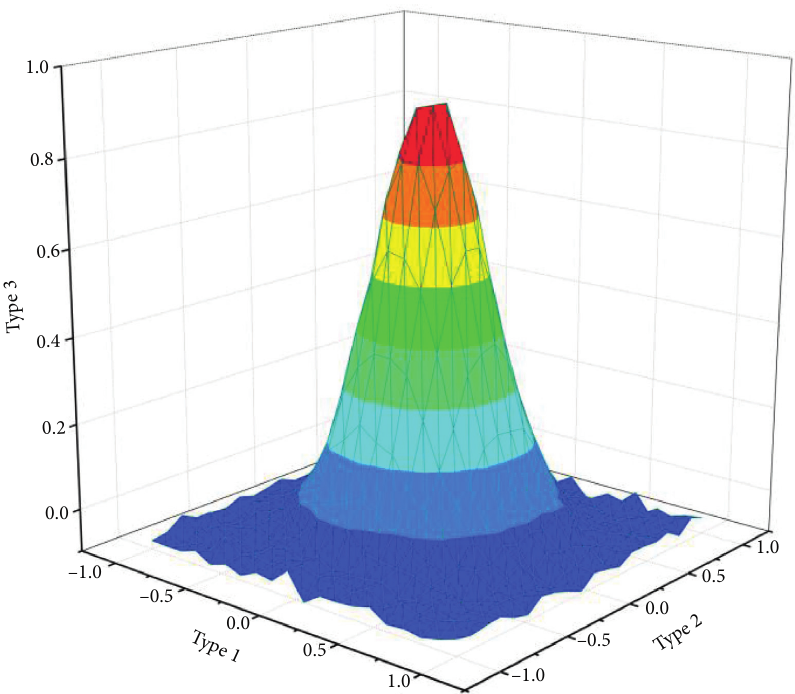
Figure 2: Virtual channel gain distribution